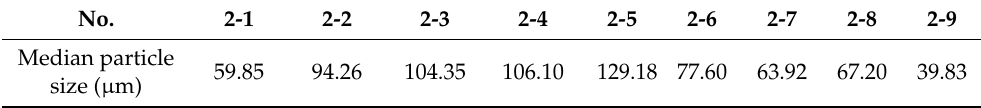
Table 5. The median particle size of samples in row 2.